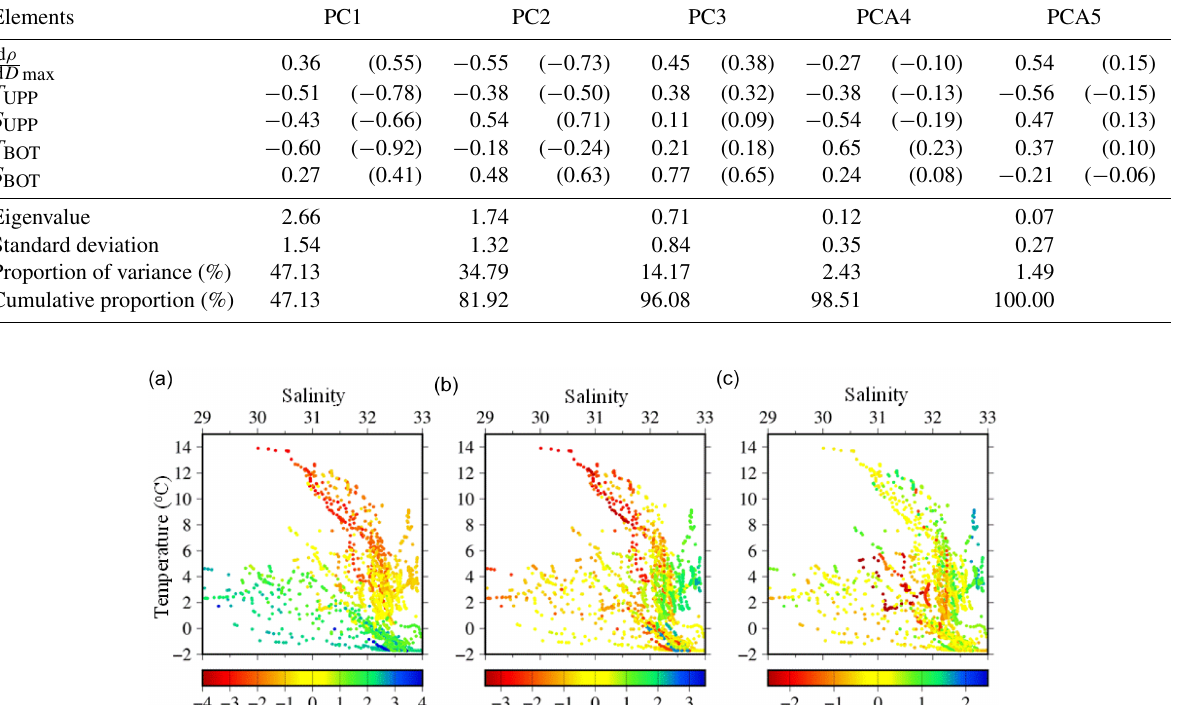
Figure 2. T - S diagrams of principal component scores (a) PC1, (b) PC2 and (c) PC3. Coloured circles indicate the magnitude of each